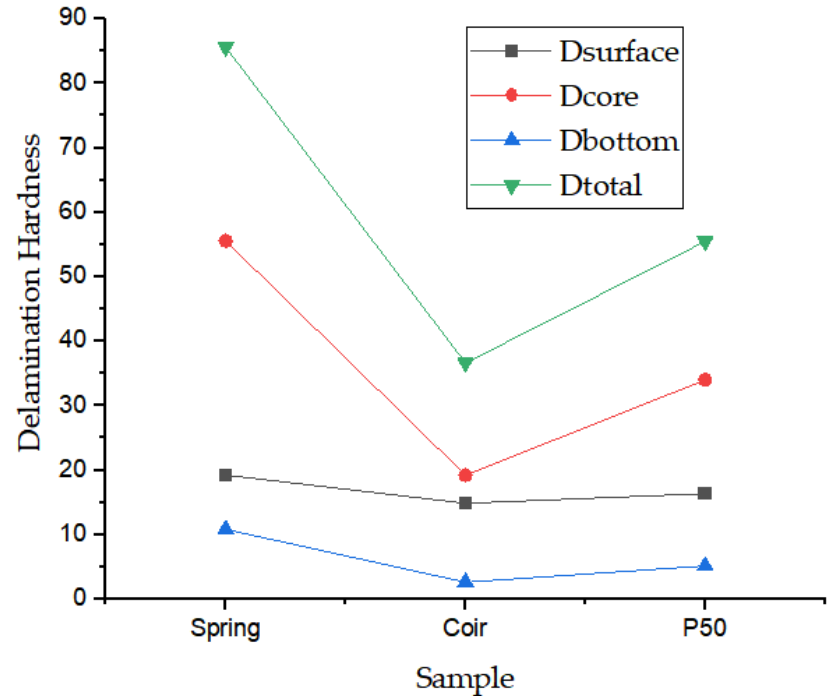
Figure 5. The mean hardness of the mattresses evaluated in this study (supporting